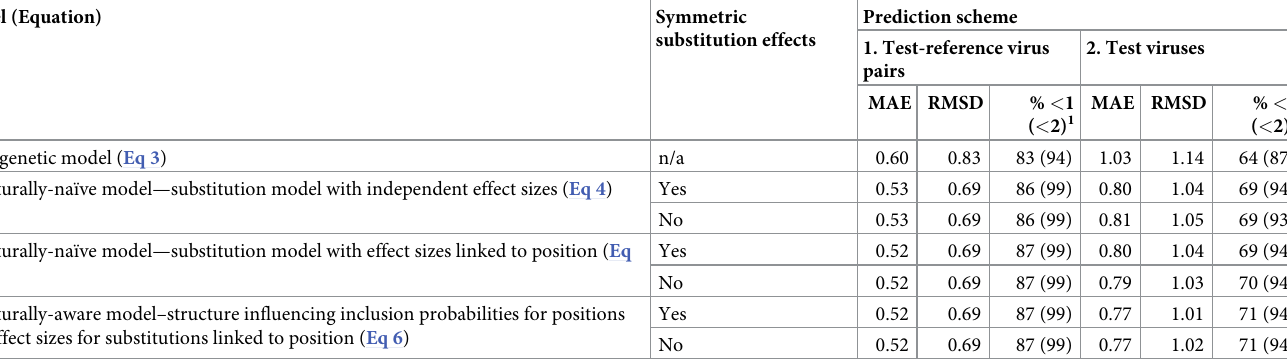
Table 3. Accuracy of genetic models in predicting antigenic phenotype. Measures of the difference between predicted and observed HI titres and the percentage of errors within 1 or 2 log 2 HI units. Model